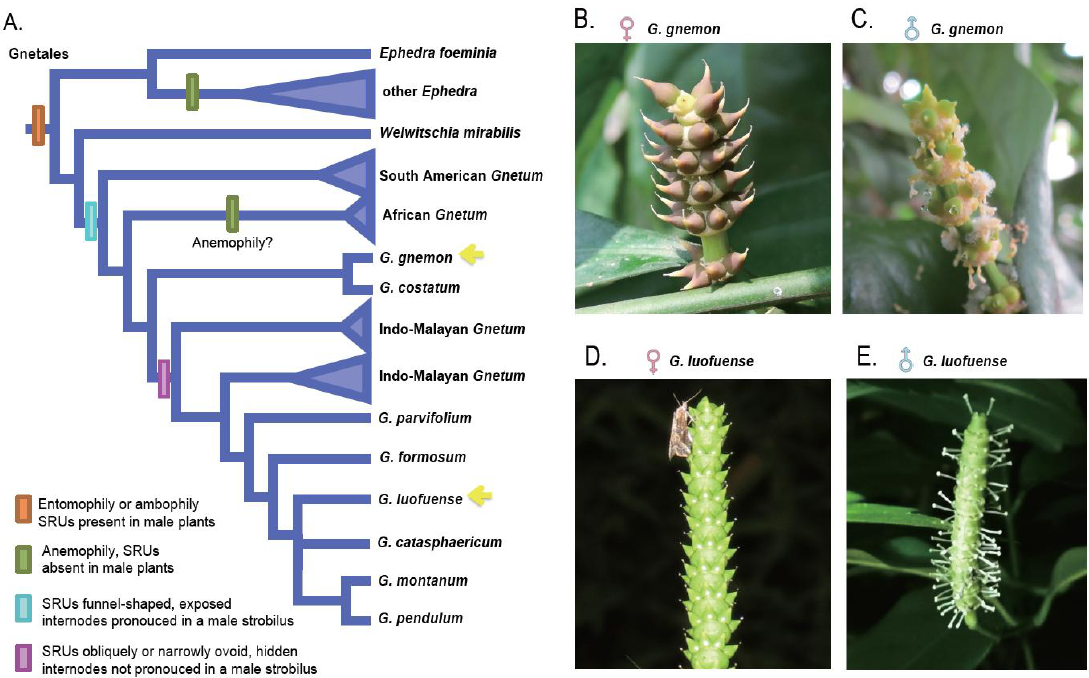
Figure 1. Reproductive evolution and morphology of Gnetum . ( A ) A schematic phylogeny illustrating the pollination biology and inferred reproductive evolution of the Gnetales (modified from Jörgensen and Rydin, 2015). Yellow arrows denote the phylogenetic placement of the two Gnetum species investigated in the present study. ( B – E ) Reproductive structures and pollination drops of G. gnemon and G. luofuense . ( B ) A female strobilus of G. gnemon . ( C ) A male strobilus of G. gnemon with sterile reproductive units (SRUs) producing pollination drops. ( D ) A female strobilus of G. luofuense with a moth sucking pollination drops from a fertile reproductive units (FRU). ( E ) A male strobilus of G. luofuense with SRUs producing pollination drops. Photographs by C. Hou.